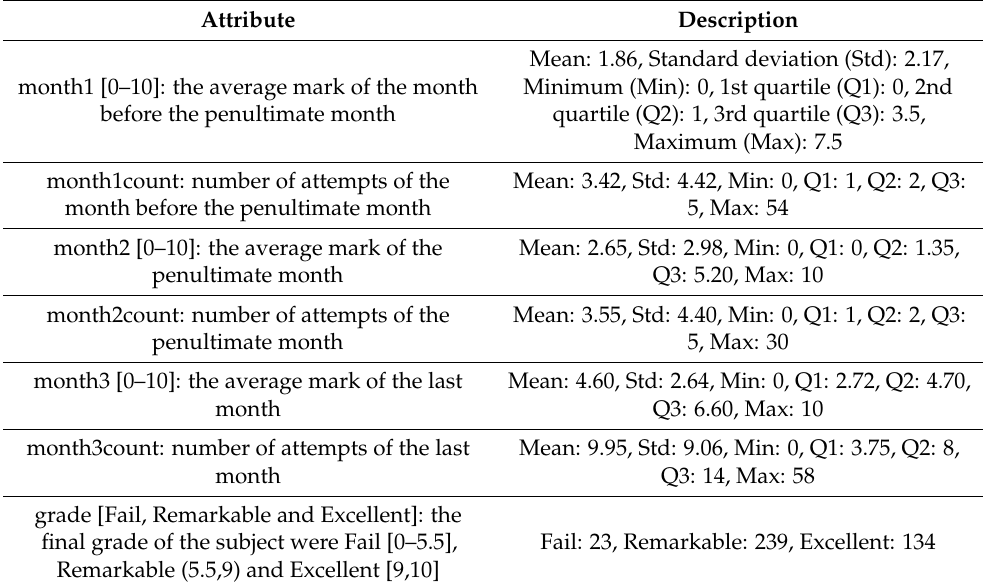
Table 1. Exploratory data analysis of the dataset. In the 1st quartile, 25% of the data is below this point. In the 2nd quartile, 50% of the data lies below this point, and in the 3rd quartile, 75% of the data lies below this